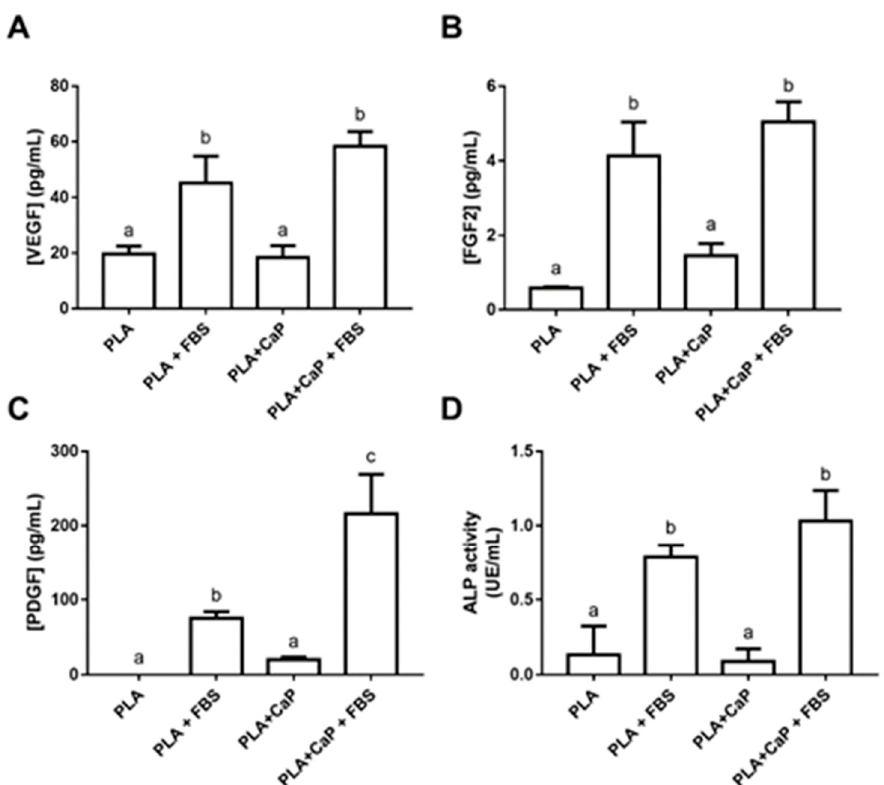
Figure 9. Evaluation of the release of biological markers into the culture media by human osteoblast spheroids after 7 days incubation inside the tested scaffolds. ( A ). Concentration of released Basic Fibroblastic Growth factor (FGF-2). ( B ). Concentration of released Vascular Endothelial Growth Factor (VEGF). ( C ) Concentration of released Platelet-Derived Growth Factor (PDGF). ( D ) Alkaline Phosphatase (ALP) activity. Bars indicate mean and standard deviation of three biological replicates with five technical replicated each. Bars with different letters are significantly different ( p < 0.05). UE: units of enzyme activity.